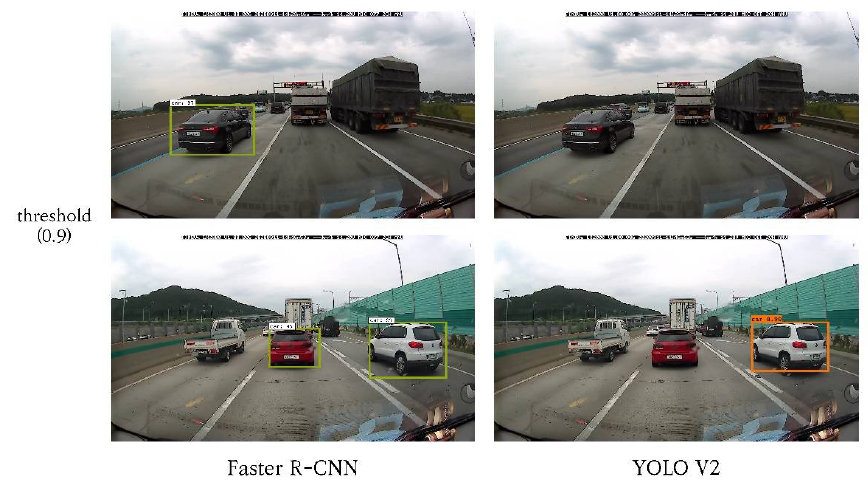
Figure 6. Learning results of object detection and classification—threshold 0.9.